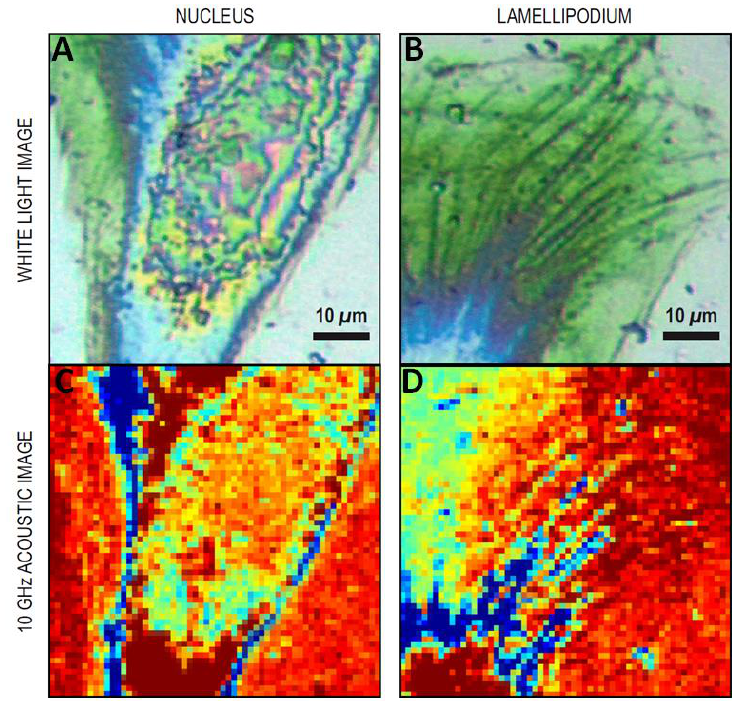
Figure 9. AOUSI cell images (taken at 10 GHz) of: the nuclear region ( C ); and lamellipodium ( D ). The upper row shows white-light images of: the nuclear region ( A ); and lamellipodium ( B ) for comparison. The scale bar of 10 mm applies to all images. The contour of the cell, the structure of the nucleus and the fine details of the fibrillar lamellipodium are clearly observed by the very high acoustic contrast. Reproduced with permission from [104], Nature Publishing Group, 2015.